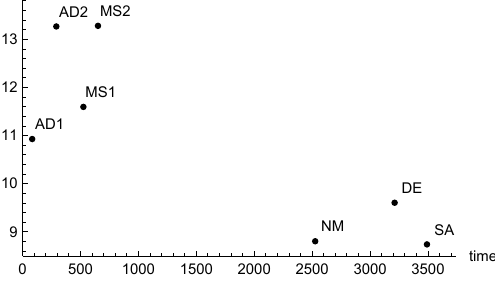
Figure 3. Average lerr (taken as a measure of accuracy) versus time